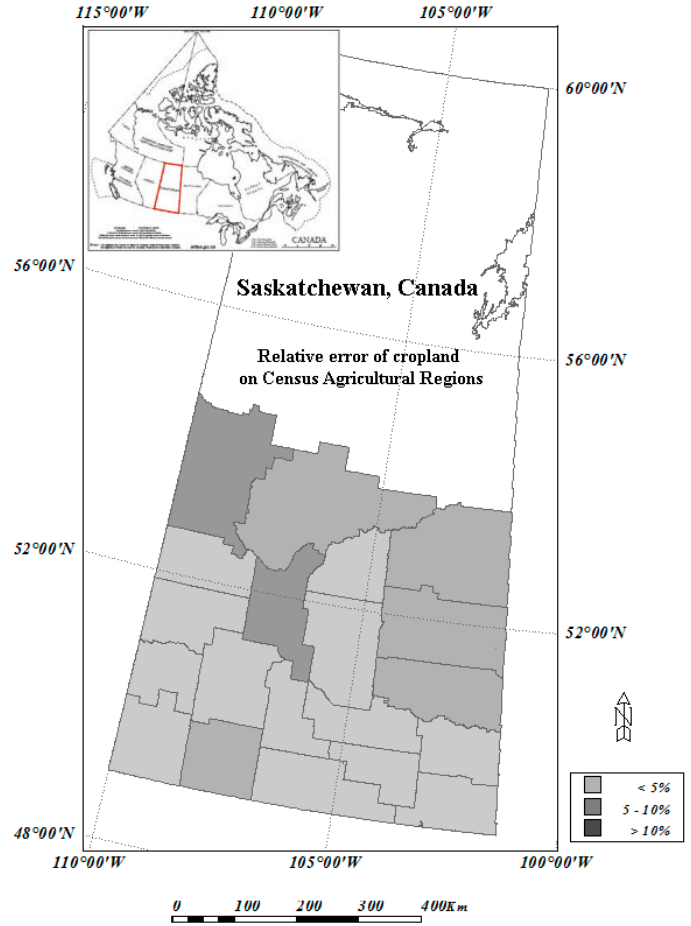
Figure 8. Relative error of cropland on Census Agricultural Regions (CARs): comparison between RF/MODIS result with the data of 2001 Census of Agriculture.